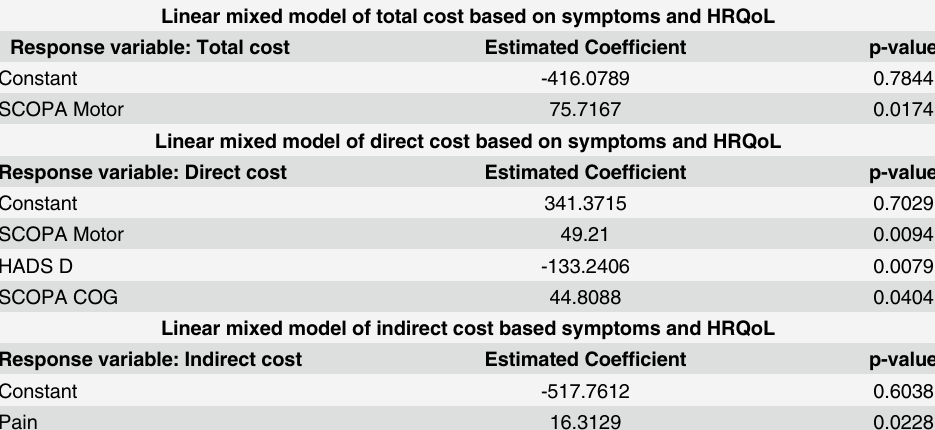
Table 4. Linear mixed model of cost based on symptoms and HRQoL. Linear mixed model of total cost based on symptoms and